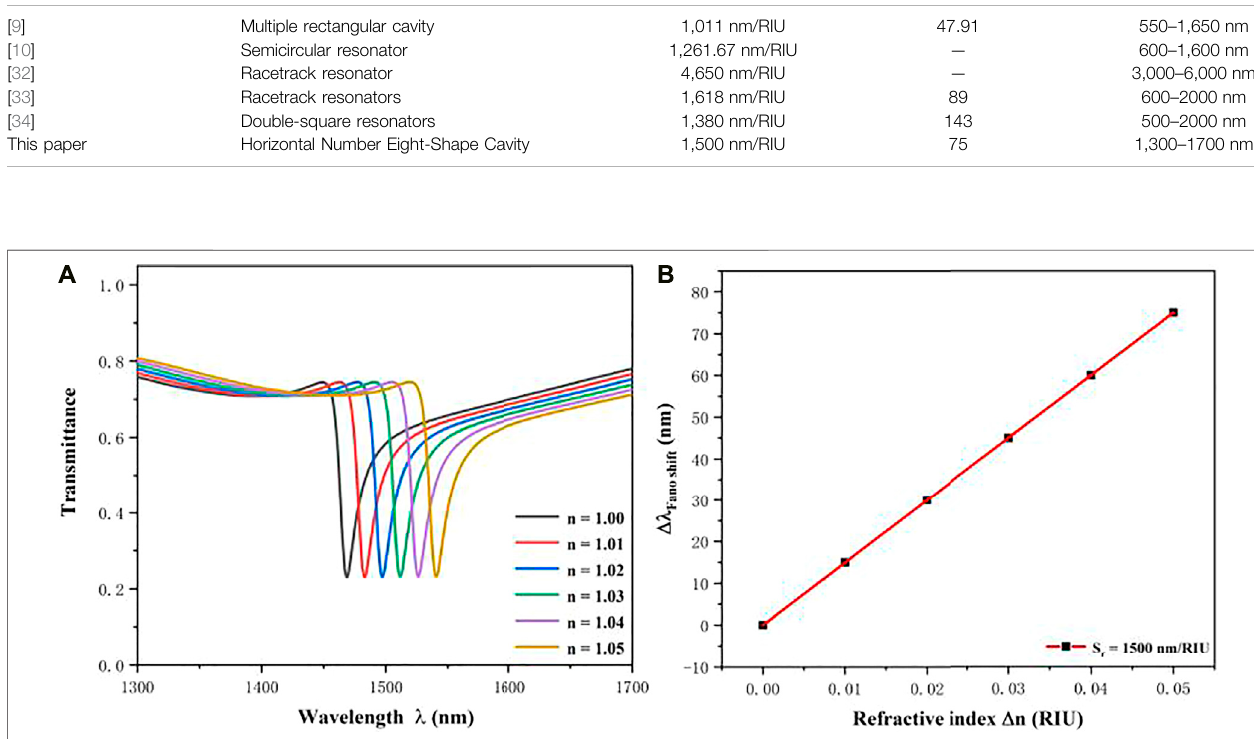
FIGURE 9 | (A) transmission spectra for variable n ; (B) fi t curve of sensitivity at R1.